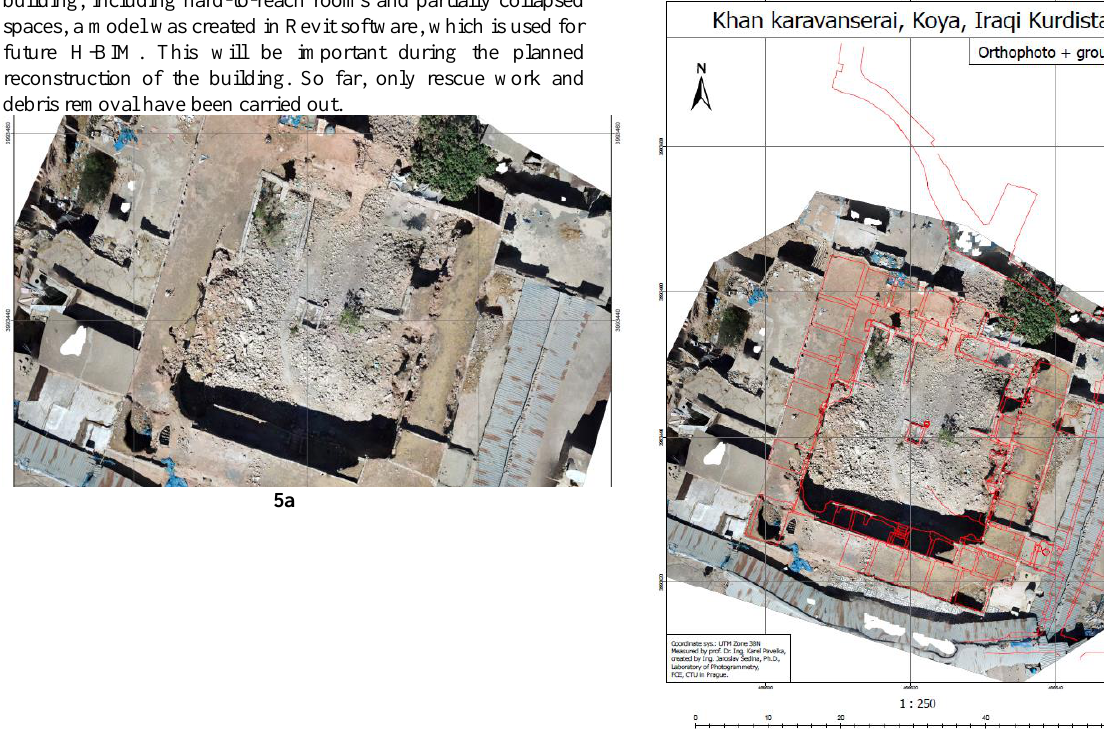
Figure 9. Orthophoto map with vector layer of the ground